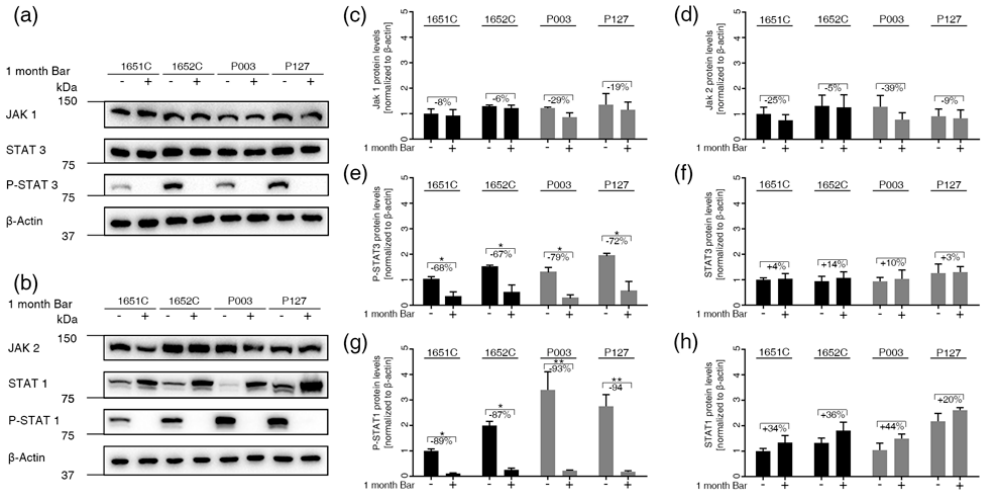
Figure 4. Status of the JAK-STAT signaling pathway in normal and HGPS cells treated with 1 µ M Bar. ( a , b ) Representative images of western blots for JAK1 / 2, STAT1 / 3, P-STAT1 / 3 and β -actin in normal (GMO1651c, and GMO1652c) and HGPS (HGADFN003, and HGADFN127) cells treated as indicated. Cultures exhibiting < 5% senescence were treated with Bar or DMSO for a period of one month. ( c ) Quantification of JAK1, ( d ) JAK2, ( e ) P-STAT3, ( f ) STAT3, ( g ) P-STAT1, and ( h ) STAT1. Graphs show the mean ± SD. Protein levels were compared by two-tailed t test (* p < 0.05, ** p < 0.01, *** p < 0.001, n > 3). 3.6. Inhibition of JAK1 and JAK2 Ameliorates Age-Related Cellular Changes in Normal and HGPS Cells Normal and HGPS cultures at ≤ 5% and ~15% SNS were treated with 1 µ M Bar or DMSO